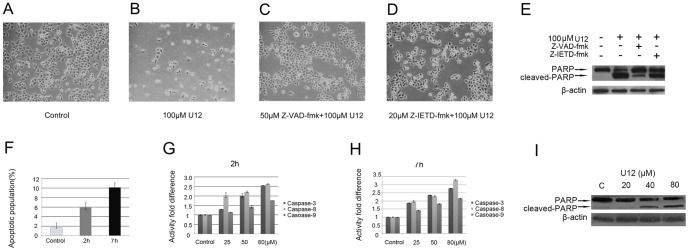
U12-induced apoptosis in SMMC-7721.Morphological and quantitative changes in SMMC-7721 cells after being (A) left untreated, (B) treated with 100 µM U12 for 24 h, or (C) pretreated with 50 µM Z-VAD-fmk or (D) 20 µM Z-IETD-fmk for 1 h. (E) Western blotting was used to estimate PARP cleavage from the 100 µM U12 for 24 h treatments. (F) Detection of apoptotic SMMC-7721 cells in the presence of 80 µM U12 for 2 h and 7 h using Annexin V-FITC/PI analysis. (G&H) Activation of caspase-3, -8, and -9 was evaluated using a caspase activity kit after indicated concentration of U12 treatment at 2 h and 7 h, respectively. (I) Western blot analysis of PARP cleavage on SMMC-7721 cells untreated and treated with indicated concentration of U12 at 12 h.